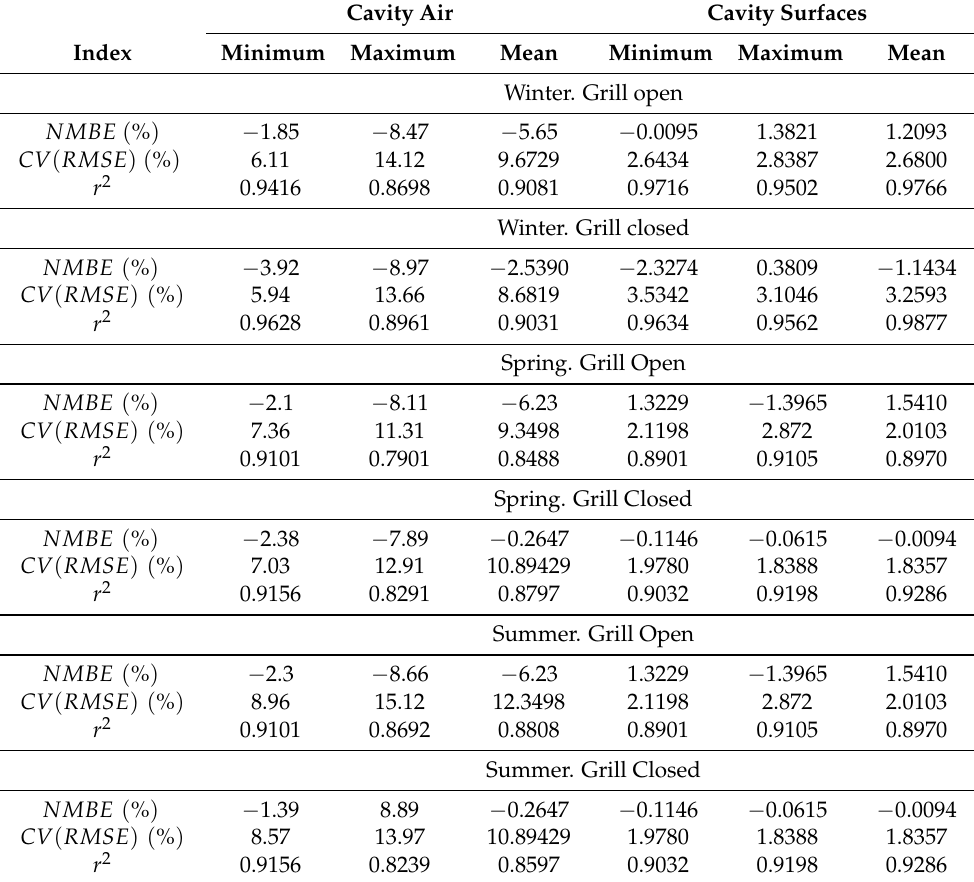
Table 6. Values of the statistical indicators for